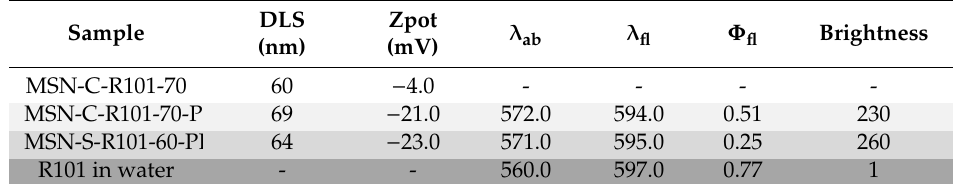
Table 3. Hydrodynamic diameter (in nm), zeta potential (in mV), absorption peak ( λ ab in nm), fluorescence peak ( λ fl in nm), and fluorescence quantum yield ( Φ fl ) in water of the dye-loaded silica nanoparticles without and with PEG-coated at their external surface.